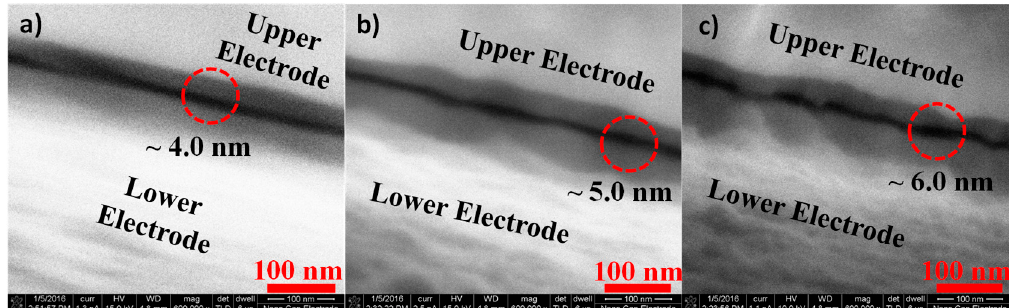
Figure 8. High-resolution SEM images of ( a ) 4.0 nm ( b ) 5.0 nm and ( c ) 6.0 nm gaps.